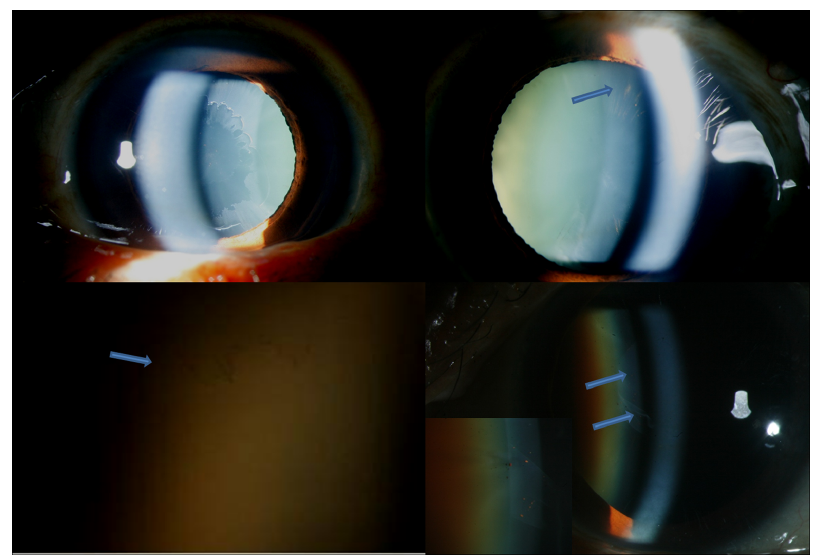
Figure 4. Slit lamp photograph showing right eye (Top left) classical peripheral pseudoexfolative ring and left eye (Top right) showing radial pigments pattern of deposits. Bottom left shows slit lamp photograph in high magnification showing coalescence of peripheral radial pigments resembling early classical peripheral ring (arrow). Bottom right shows slit lamp photograph showing central classical pseudoexfoliation ring with anterior curling of the sheet (Blue arrows) with inset showing interspersed radial pigment deposits.